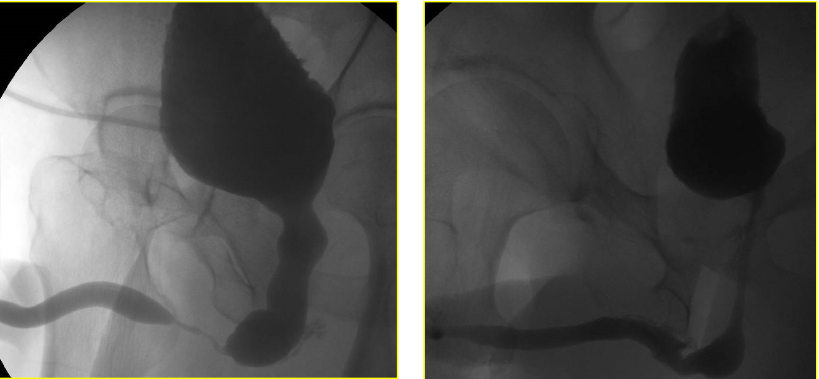
Figure 4. Retrograde urethrogram in a patient with a 2.1 cm stricture pre and 24-h post double-layer running suture re-anastomosis.